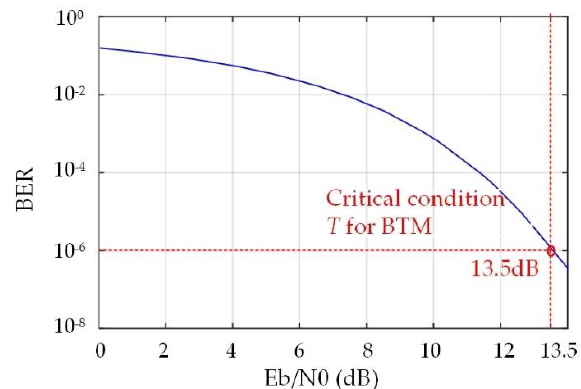
Figure 15. Relationship between SNR and BER of BTM signal.